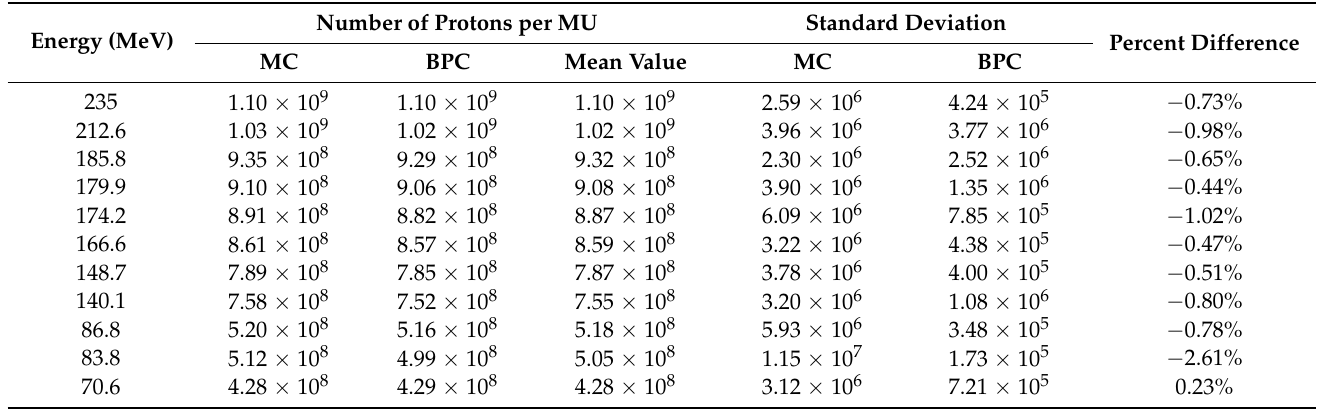
Table 2. Number of protons per MU and the standard deviation derived from Markus chamber and Bragg peak chamber